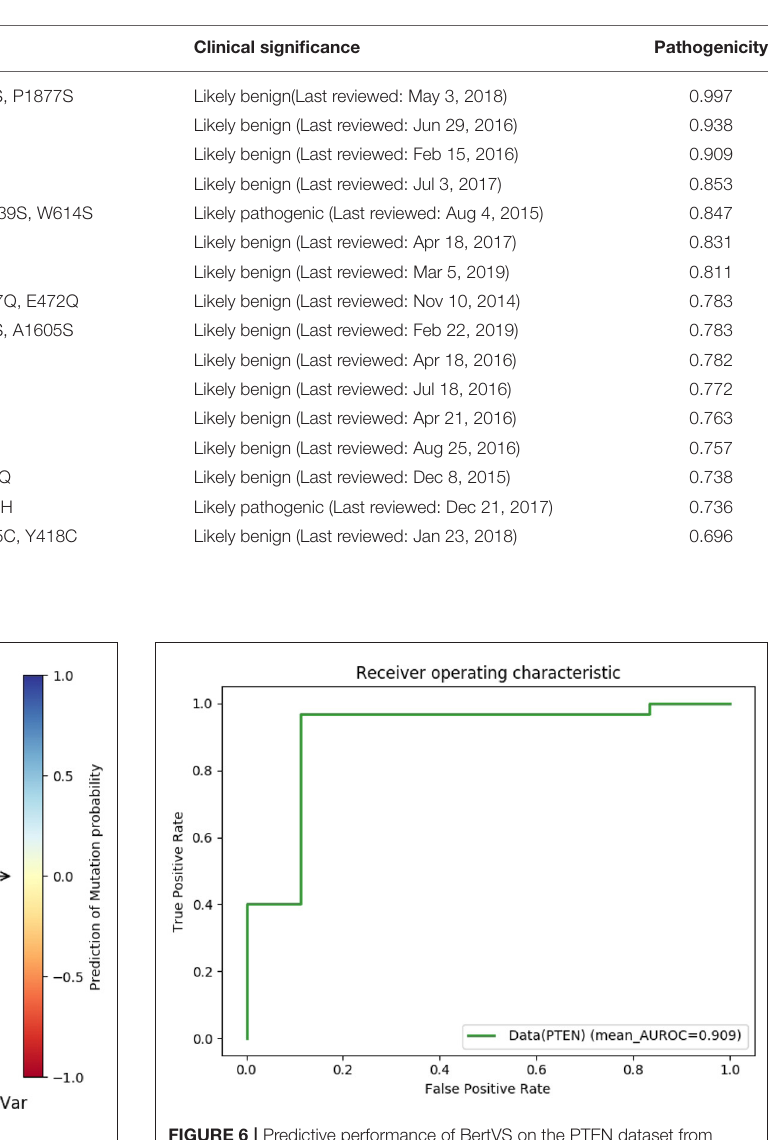
PTEN needs to add negative samples as noise. The same